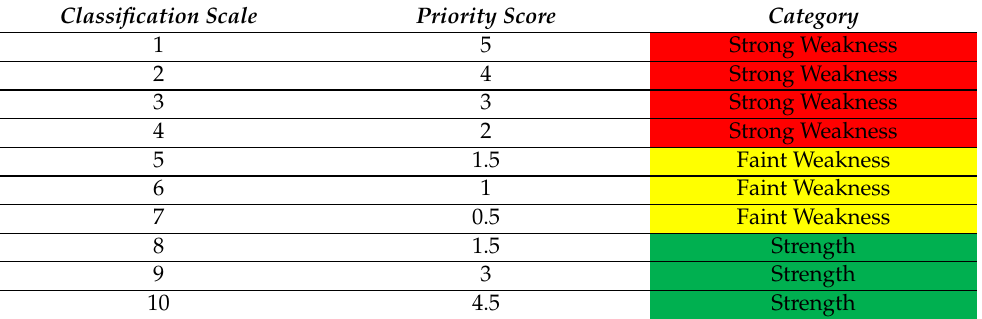
Table 2. Conversion table. Weaknesses have a descending consecutive scoring system, from 5 to 2 for strong weaknesses, and from 1.5 to 0.5 for faint weaknesses, and strengths have an increasing consecutive scoring system from 1.5 to 4.5. The priority score is to be inserted into the NGSA. The category is colored depending on the streetlight color system. Classification Scale Priority Score